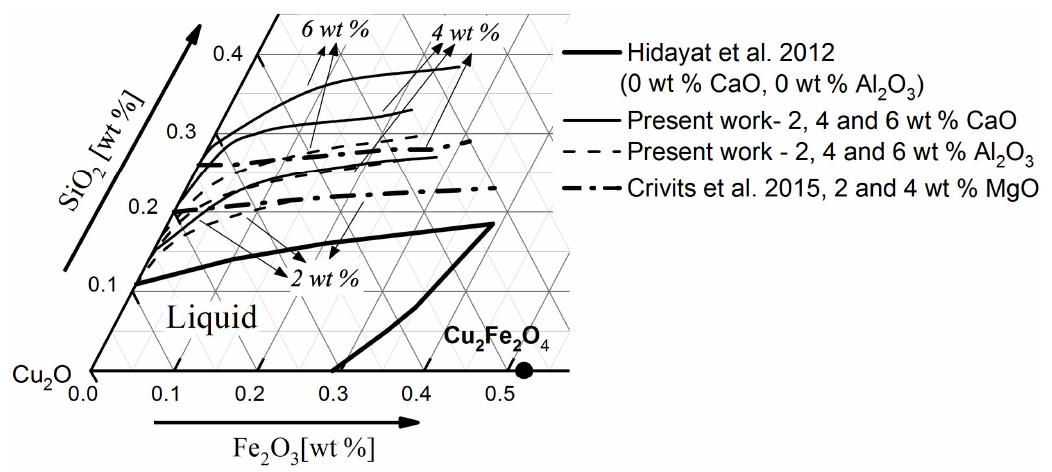
Figure 11. Liquidus for the equilibrium slag / tridymite of the Cu 2 O–Fe 2 O 3 –SiO 2 system with di ff erent additions of CaO and Al 2 O 3 at 1200 ◦ C, in equilibrium with metallic